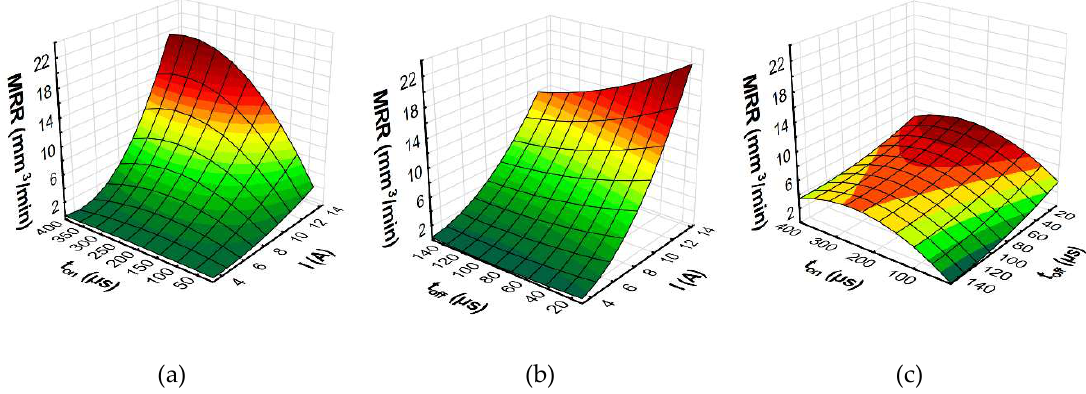
Figure 16. The estimated response surface plot for the MRR: ( a ) constant t off = 80 μs; ( b ) constant t on = 206 μs; and( c ) constant I = 8.5 A.